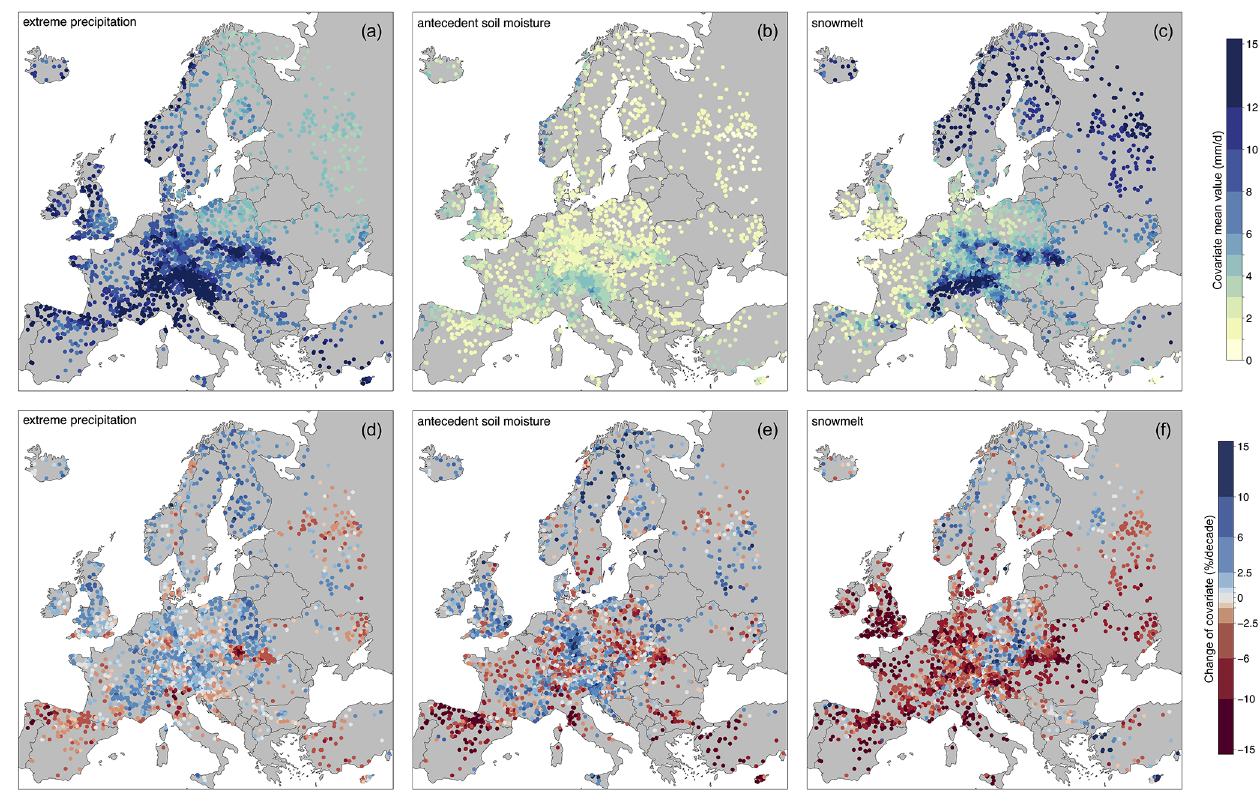
Figure 3. Mean value and change of catchment-averaged extreme precipitation (a, d) , antecedent soil moisture (b, e) and snowmelt (c, f) for each station over the period